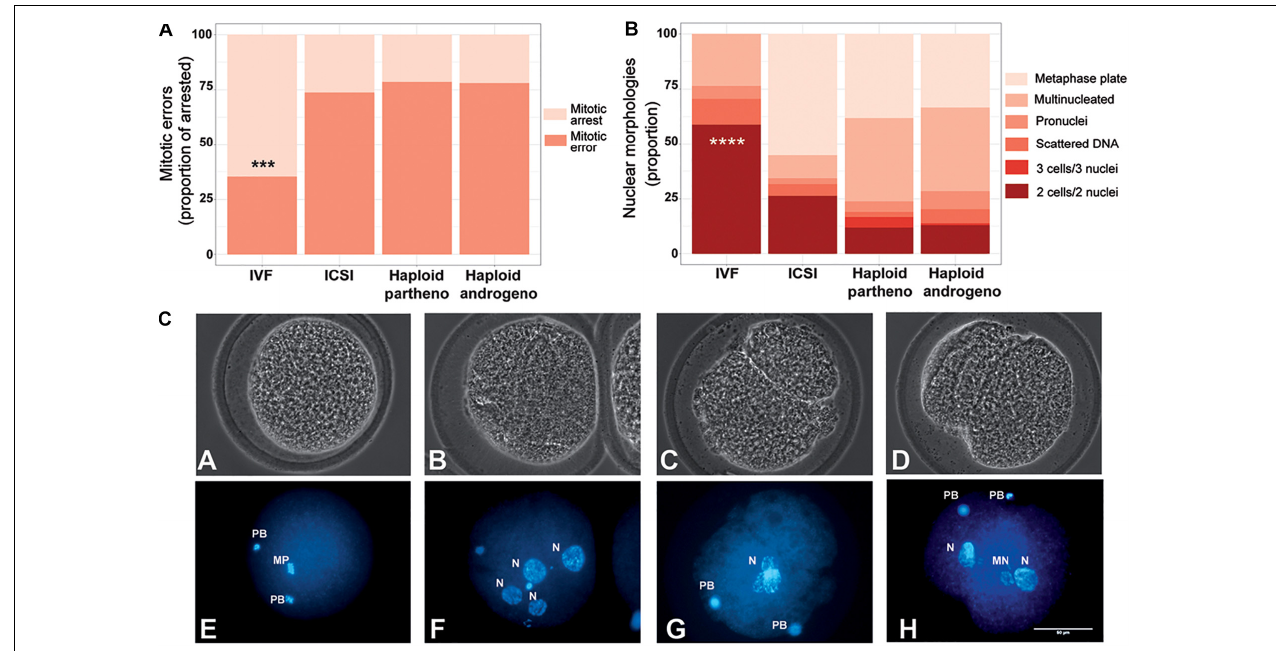
FIGURE 6 | Developmental patterns of arrested embryos at 2- to 3-cell stage. (A) Proportion of embryos showing mitotic errors in relation to total number of arrested embryos. (B) Nuclear morphologies found in the zygotes showing developmental arrest. (C) Representative images of developmentally arrested embryos; (A,E) non-activated oocyte, (B,F) multinucleated zygote, (C,G) Anucleate blastomere, (D,H) Micronuclear formation. PB, polar body; mp, metaphase plate; n, nucleous; mn, micronucleus; ICSI, intracytoplasmic sperm injection using female-sorted semen; haploid partheno, haploid parthenogenetic embryos obtained by oocyte activation using ionomycin followed by cyclohexymide; haploid androgeno, haploid androgenetic embryo obtained by ICSI + oocyte enucleation. ∗∗∗ p < 0.001, ∗∗∗∗ p < 0.0001. Scale bar 50 µ